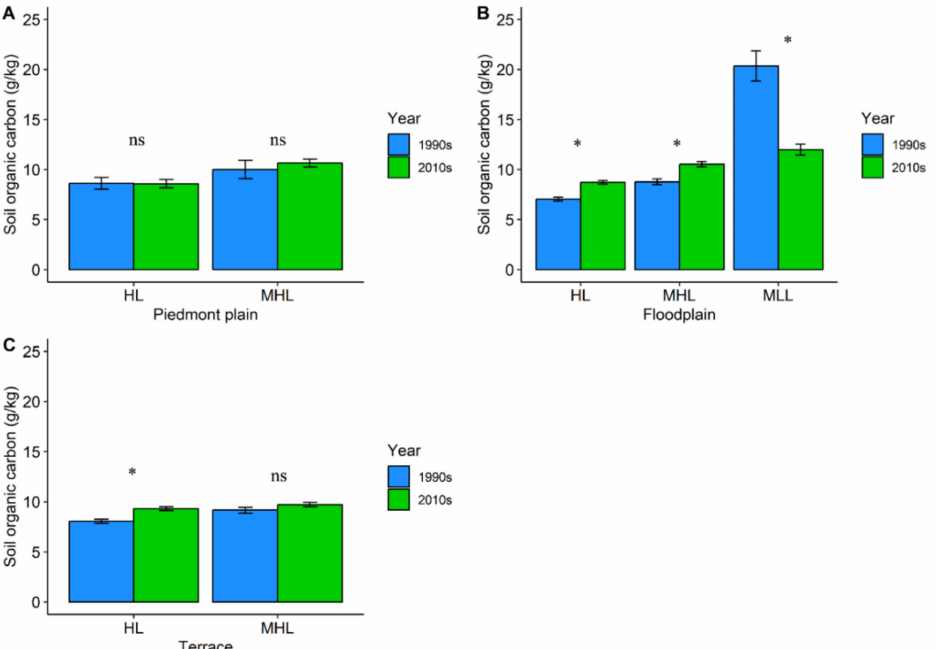
Figure 5. Soil organic carbon (SOC) contents (0–15 cm) across land types sampled in 1990s and 2010s in the ( A ) Piedmont plain, ( B ) Floodplain and ( C ) Terrace physiography. The error bars represent respective standard errors. The significant difference is indicated by ‘*’ and non-significant difference is indicated by ‘ns’ sign.